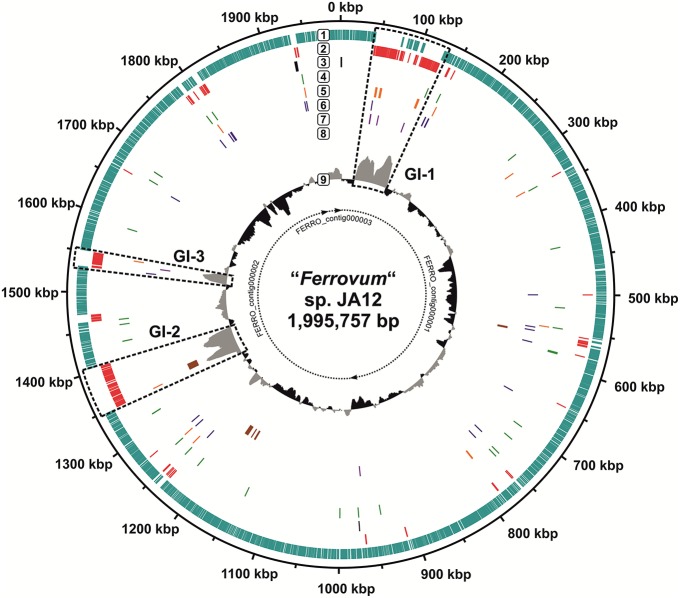
Potential genomic islands in group 2 strain JA12. The circular representation of the genome of group 2 strain JA12 was visualized using Artemis (Rutherford et al., 2000) and DNAPlotter (Carver et al., 2009). The borders of the contigs are given in the center (nucleotide accession numbers: FERRO_contig000001, LJWX01000001; FERRO_contig000002, LJWX01000002; FERRO_contig000003, LJWX01000003). The putative genomic islands are named GI-1, GI-2, and GI-3. The rings are numbered from the outside to the inside: 1. coding sequences with normal codon usage (turquoise); 2. putative alien genes (red); 3. rRNA genes (black); 4. tRNA genes (green); 5. predicted integrases (orange); 6. predicted transposases (blue); 7. predicted phage-associated genes (purple); 8. VirB/D4 secretion system (brown); 9. G+C content (gray, above genome average; black, below genome average). The predicted donors and gene functions of the putative alien genes are provided in Supplementary Figure 4 and Supplementary Table 5.